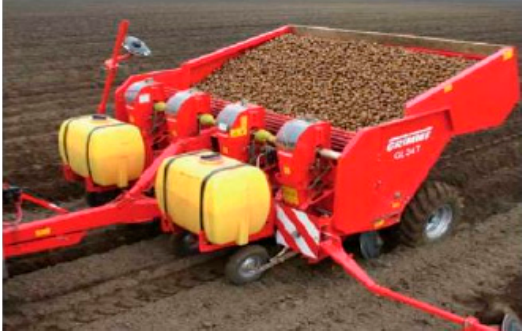
Figure 27. Grimme GL-34T potato planter. Reprinted with permission from ref. [97]. Copyright 2018 Grimme Industries.